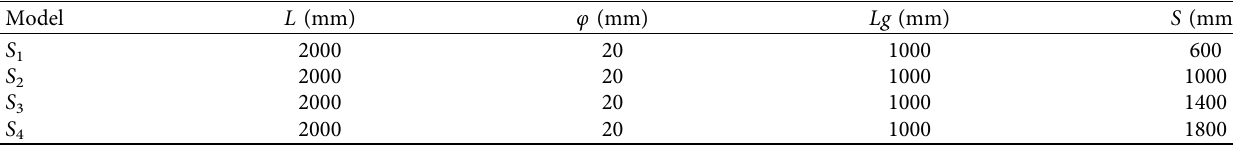
Table 13: Model design with different grouting lengths.